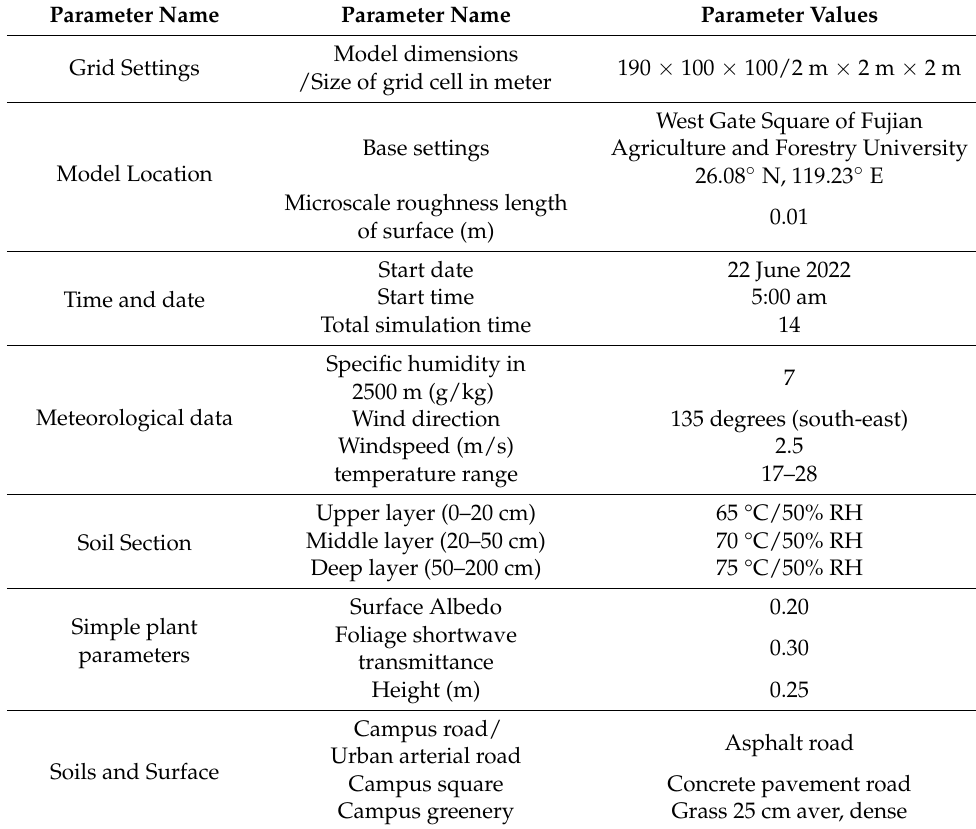
Table 1. Parameter settings of